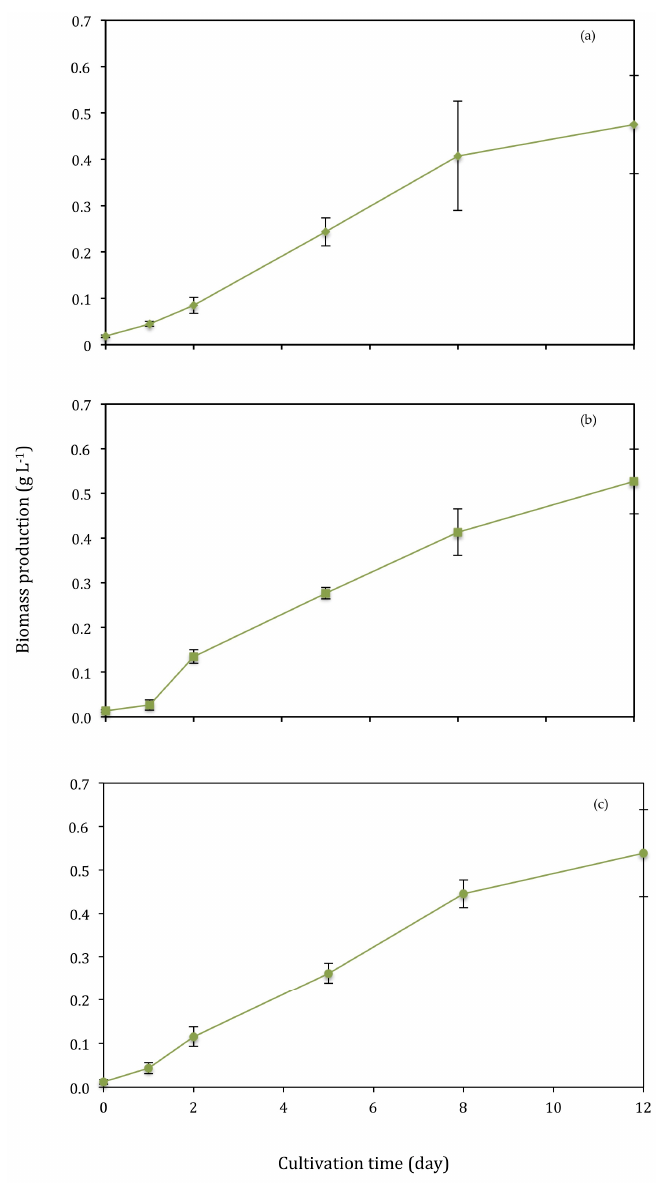
Figure 5. ( a ) Control ( b ) T1 ( c ) T2. Biomass production, determined by dry weight (g L − 1 ). Bars represent SD.